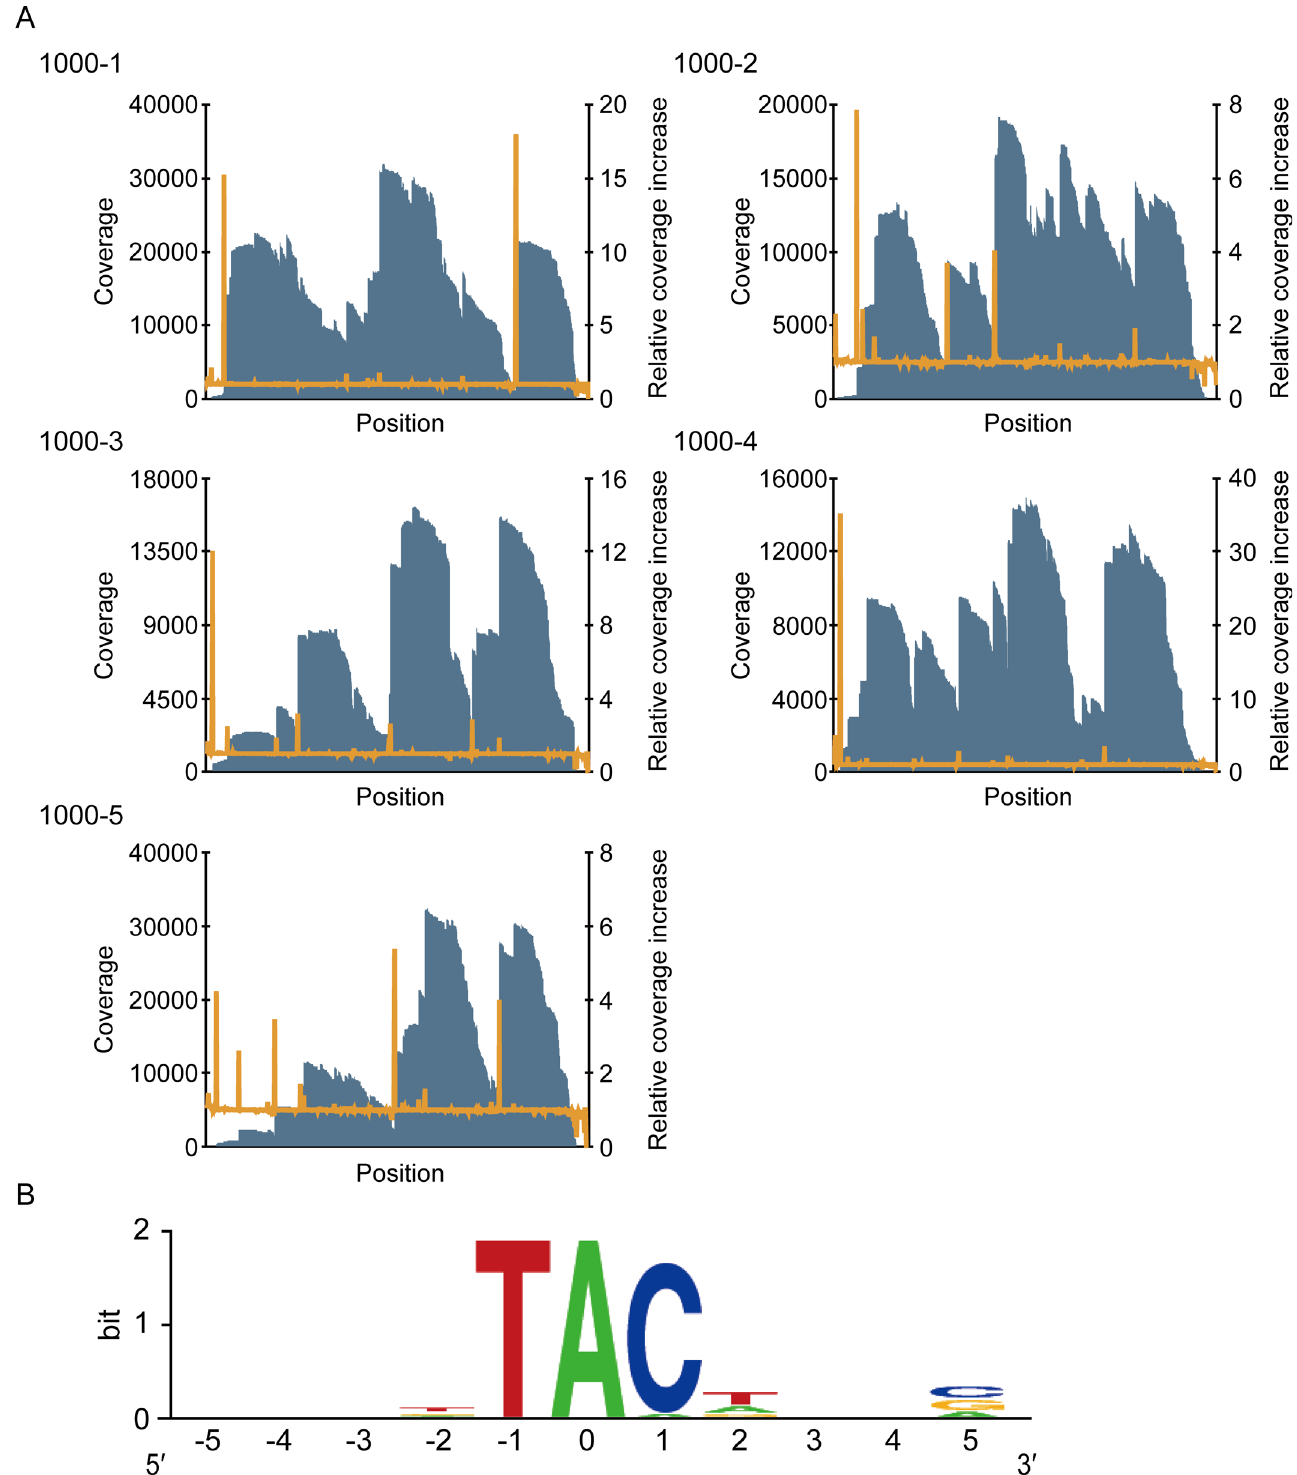
Fig 4. Analysis of the cleavage sequence of MazFpp. (A) Graph of the coverage (blue bar) and the relative coverage increase (orange line). (B) The conserved sequence around nucleotide positions with increased coverage. The nucleotide position with significant increases in coverage was set to zero.